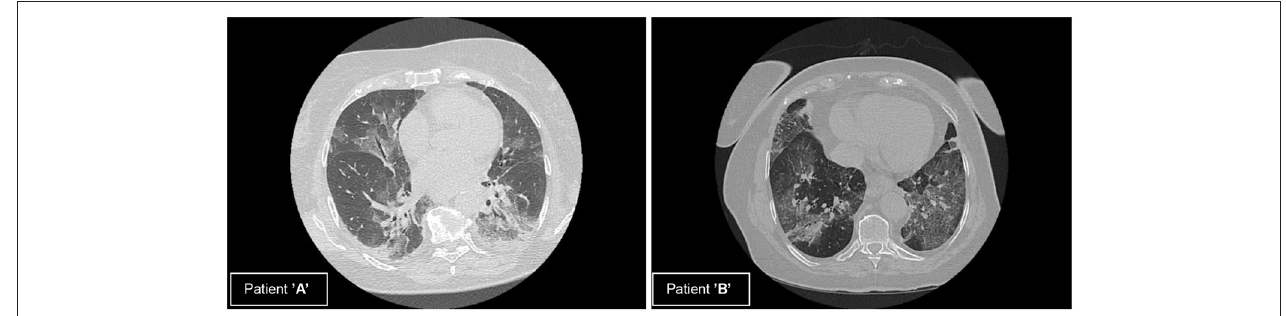
FIGURE 1 | Computed tomography (CT) scans of patients (A) and (B) . (A) Multifocal, subpleural, bilateral ground glass opacities with subpleural traction in the dorsal regions. (B) Multifocal, subpleural, bilateral ground glass opacities, crazy paving dominantly on the left side, consolidation in the right basal